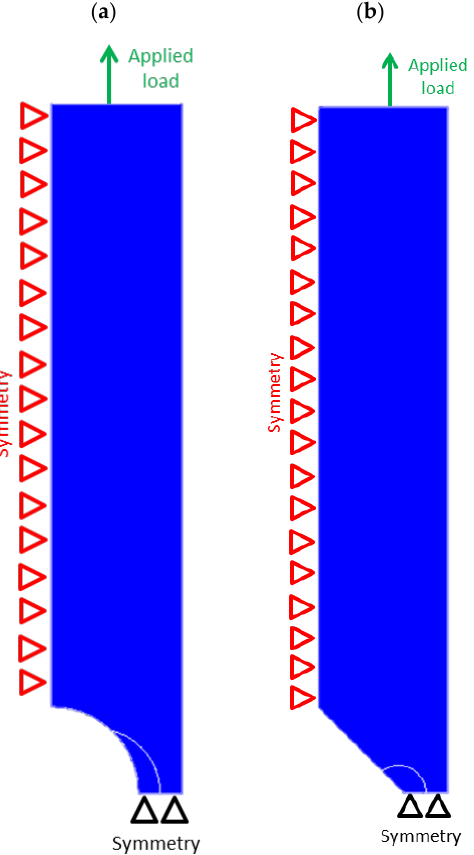
Figure 5. Boundary conditions in FE models for specimens weakened by a semi-circular notch ( a ) and a blunt V-notch ( b